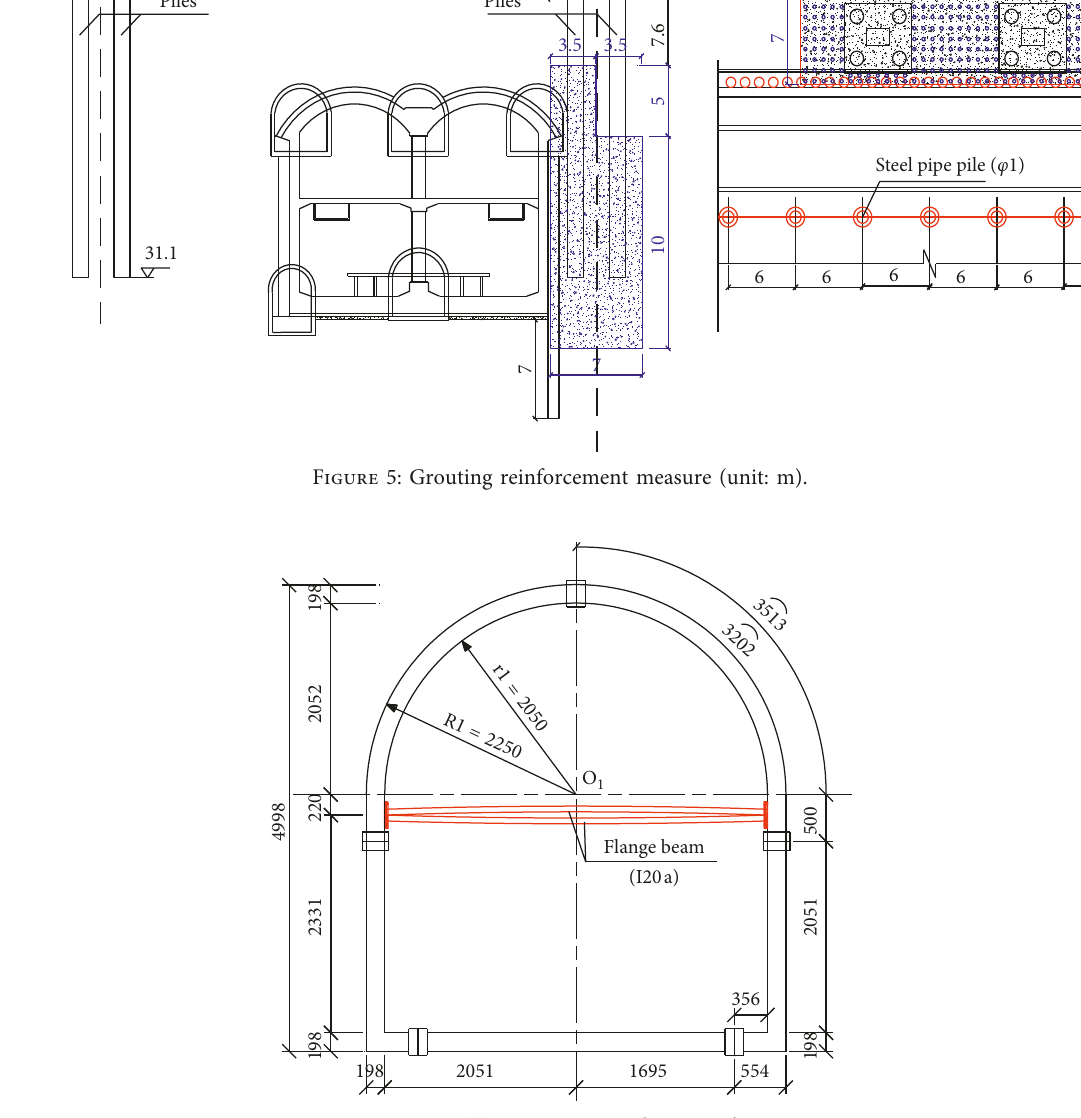
Figure 6: Temporary invert (unit: